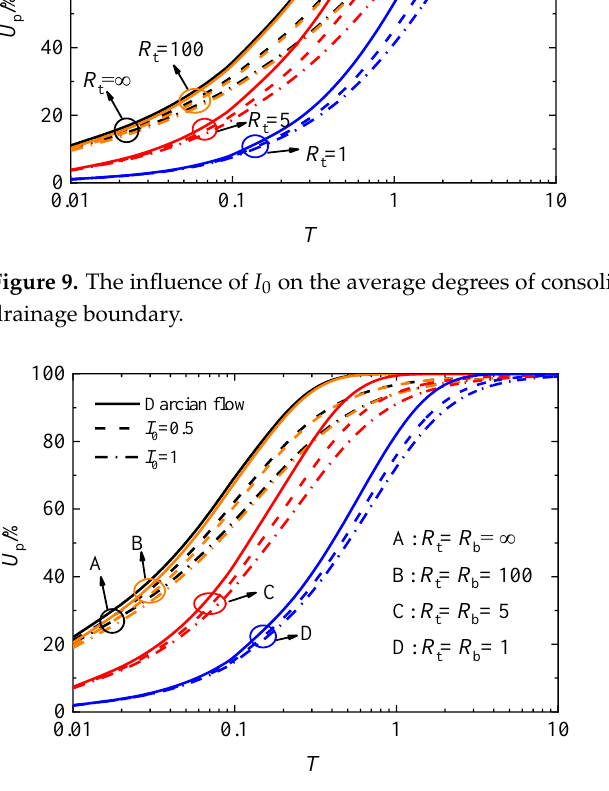
Figure 10. The influence of I 0 on the average degrees of consolidation under a double-side impeded drainage boundaries.